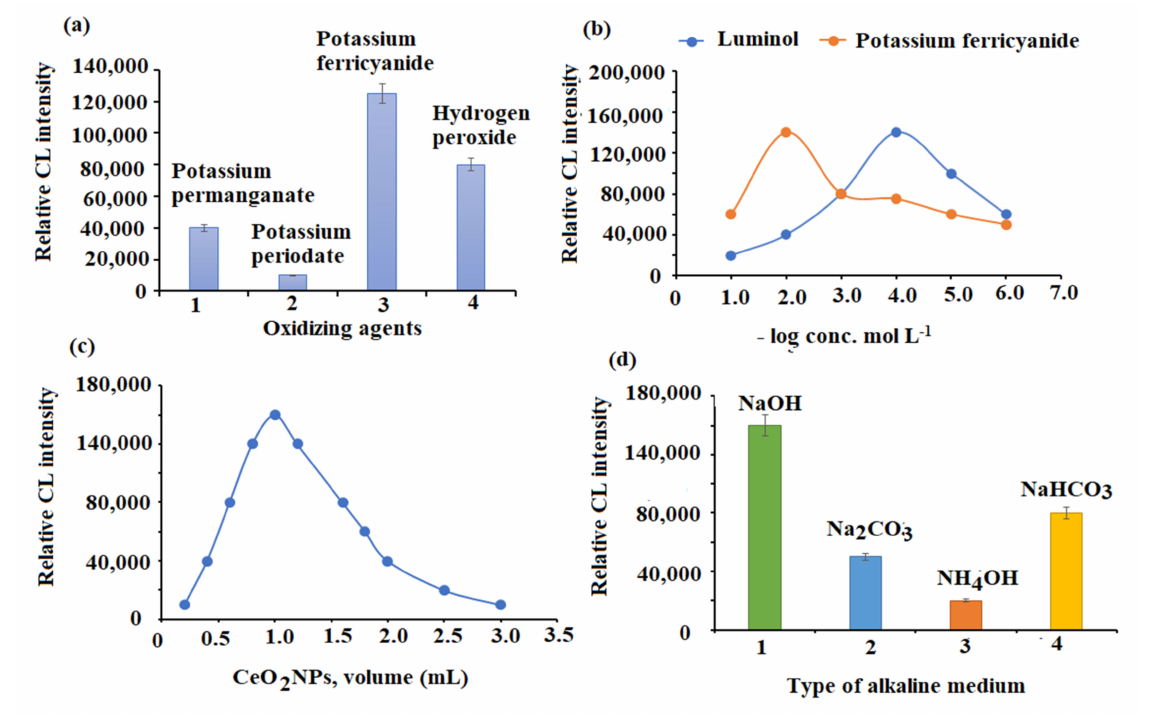
Figure 7. Optimization of SIA conditions: ( a ) selection of suitable oxidizing agent, ( b ) effect of luminol and potassium ferricyanide concentrations, ( c ) effect of CeO 2 NPs volume, and ( d ) selection of suitable alkaline